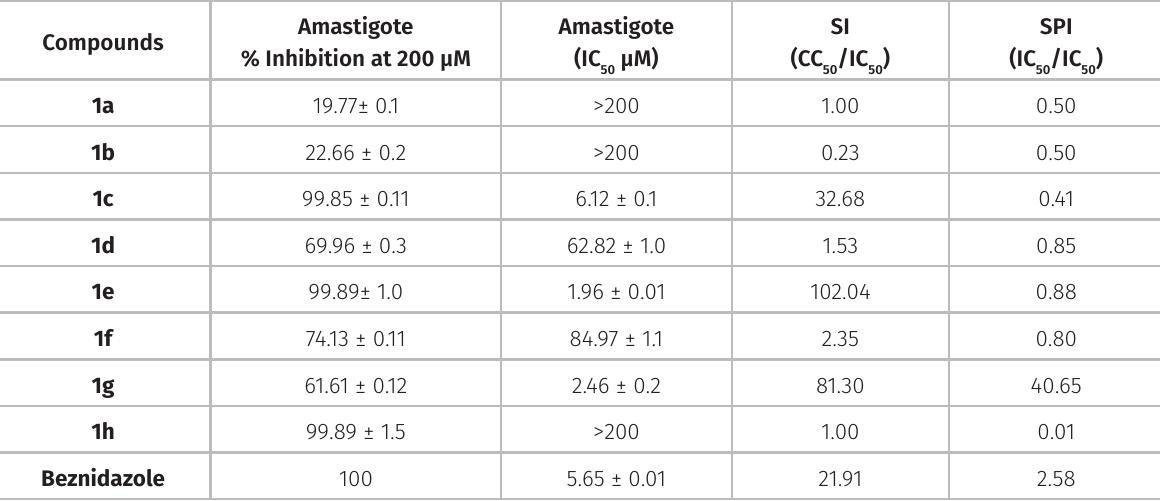
Table VI. Antiamastigote activity results obtained by the compounds expressed as percentage of inhibition at a concentration of 200 µM in addition to IC values and selectivity 50